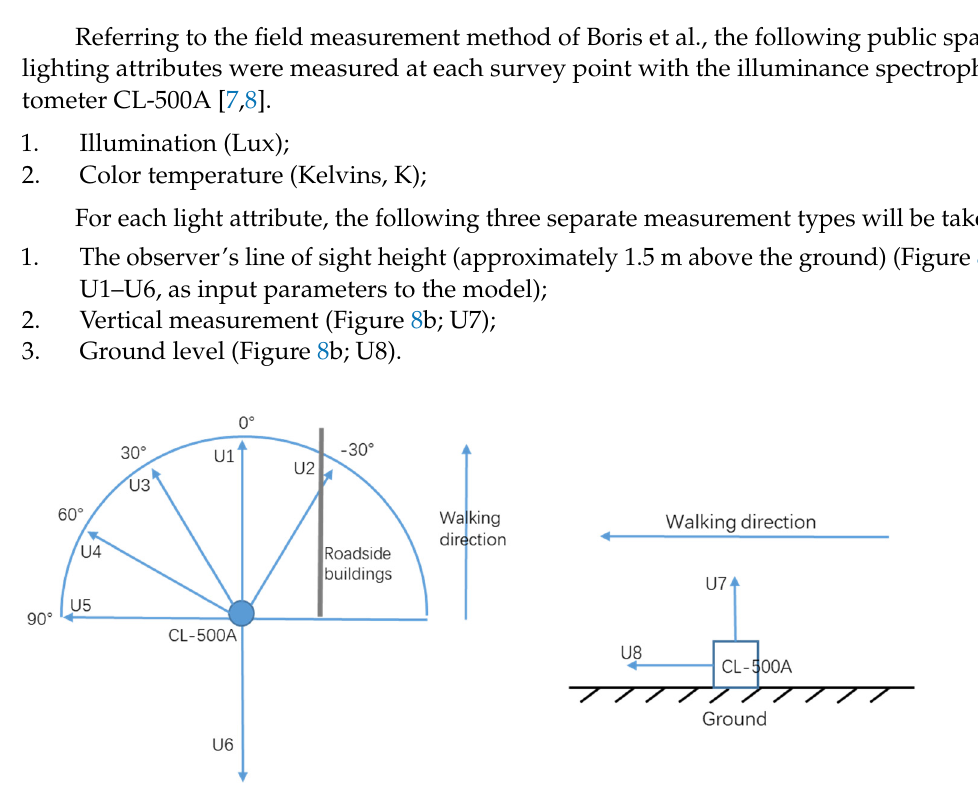
Figure 7. Chongwenmenwai street typical residential area survey route and survey points designation.